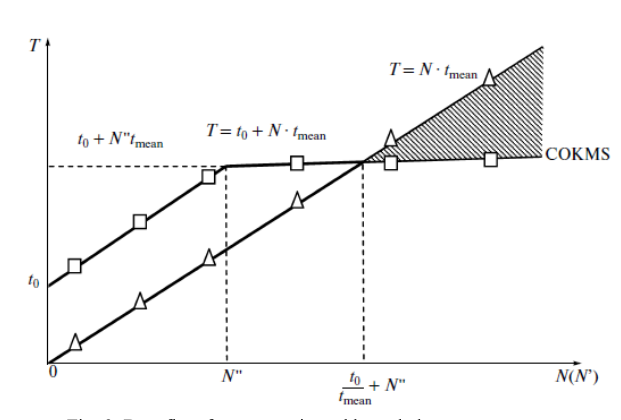
Fig. 9. Benefits of context-oriented knowledge